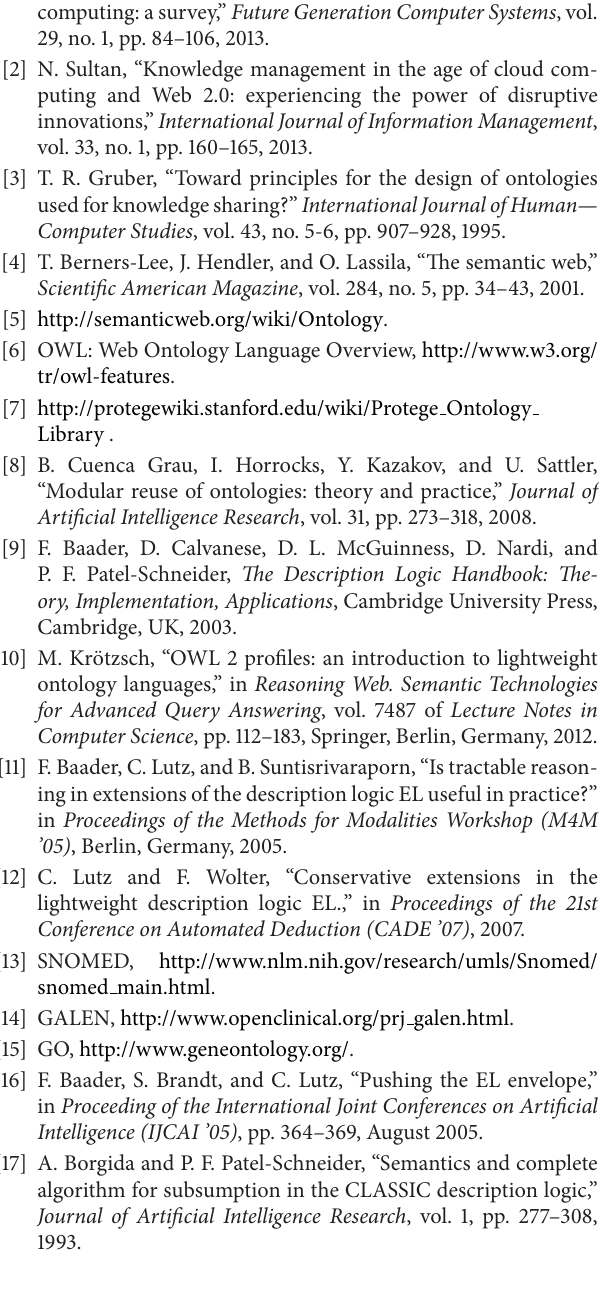
Algorithm 4: Algorithm of module extraction (constructing mod- ule hierarchy